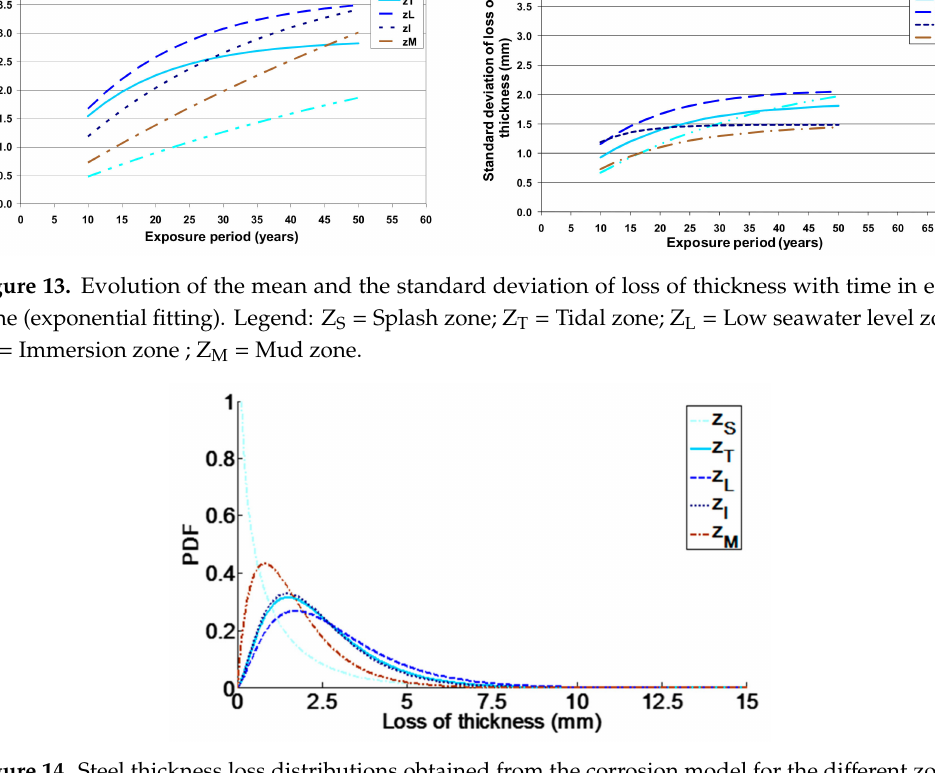
Figure 14. Steel thickness loss distributions obtained from the corrosion model for the di ff erent zones over a time period t = 25 years.